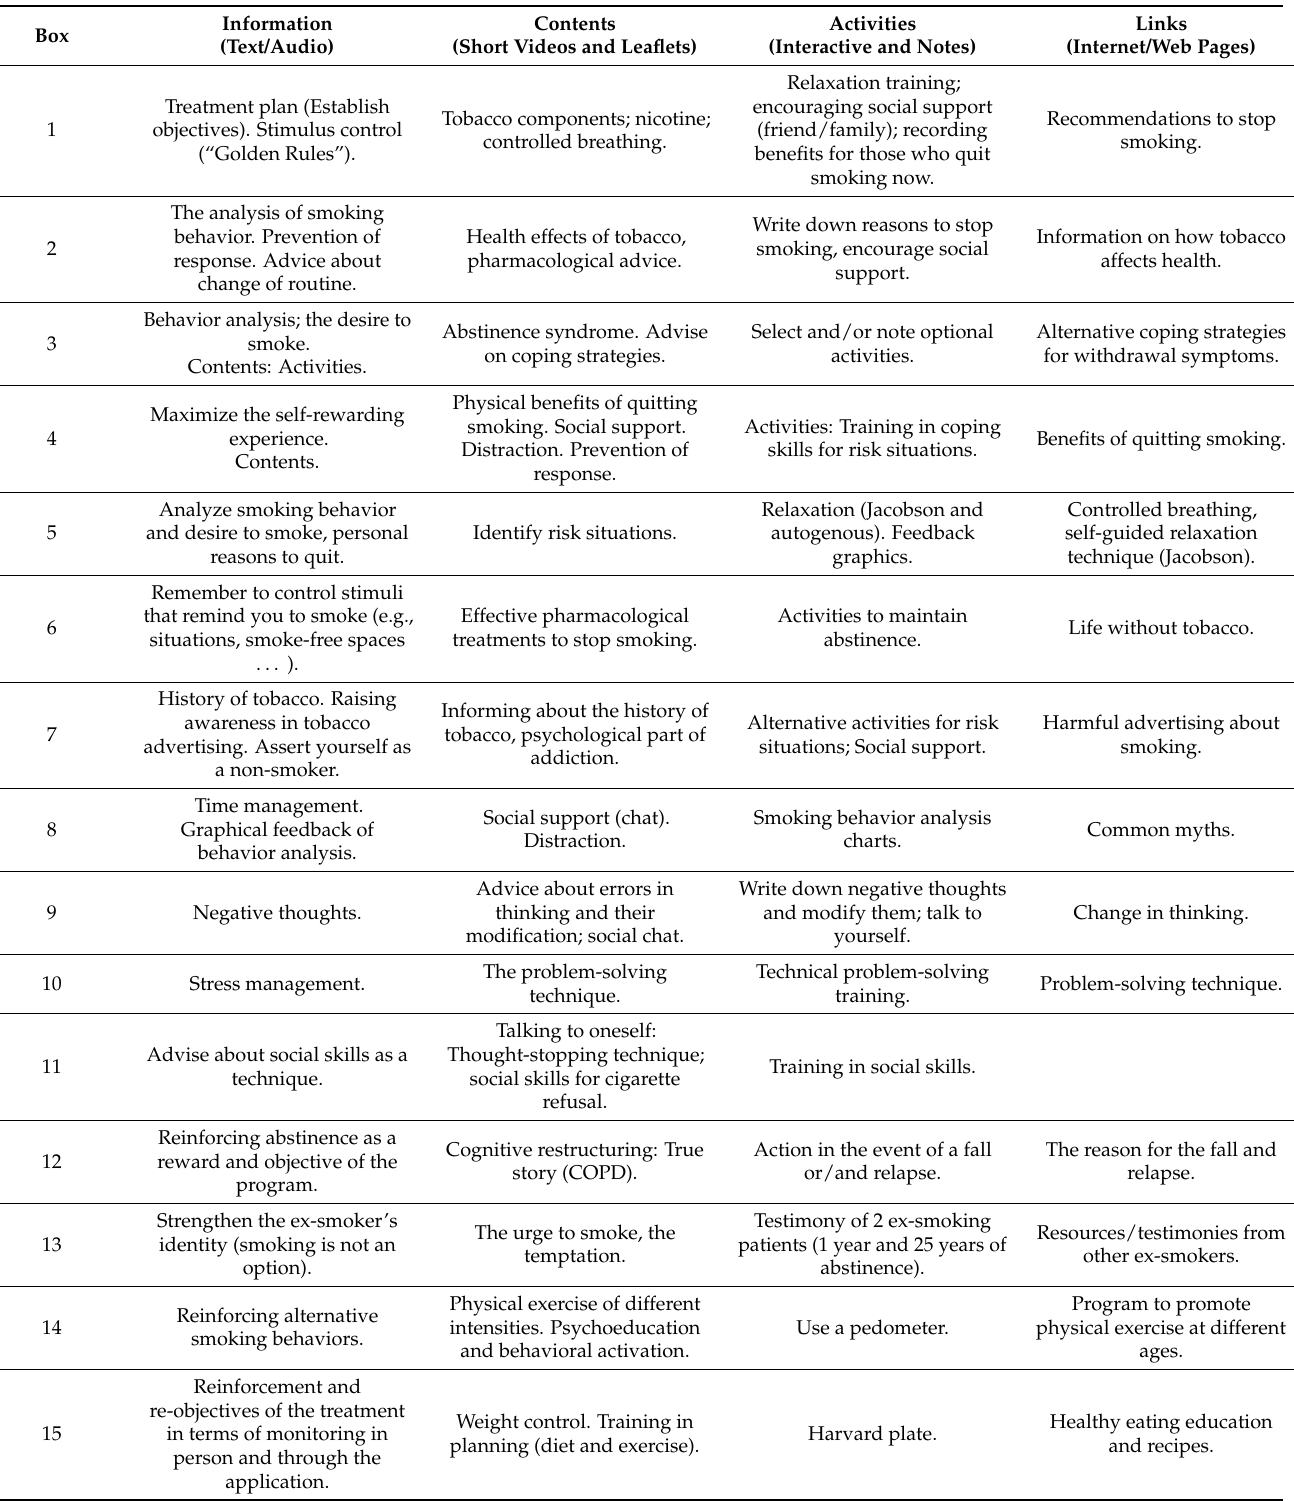
Table 1. NoFumo+ app multicomponent